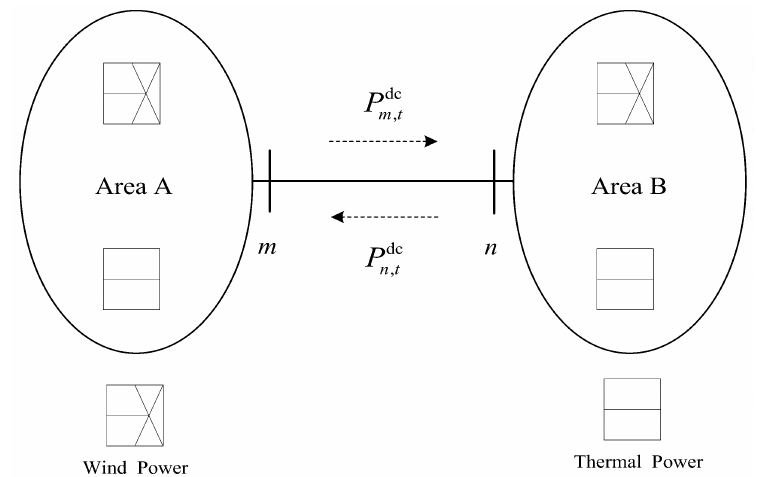
Figure 1. Schematic diagram of interconnected power